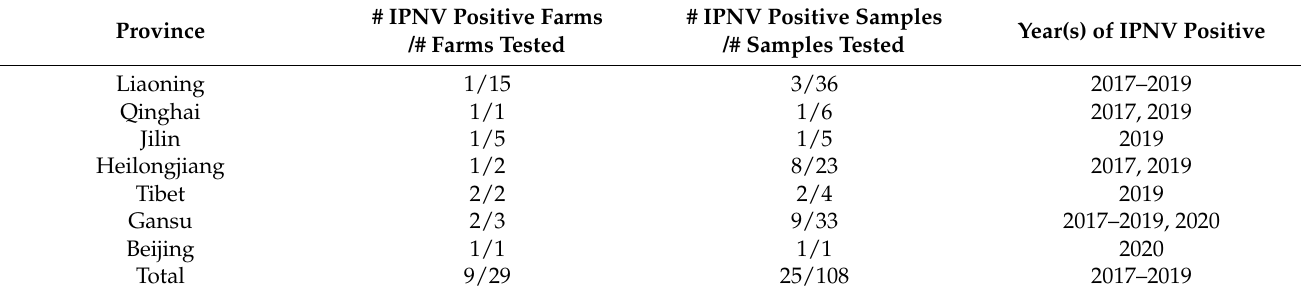
Table 1. Passive surveillance for infectious pancreatic necrosis virus (IPNV) in Chinese salmonid fish from 2017 to 2020. Province